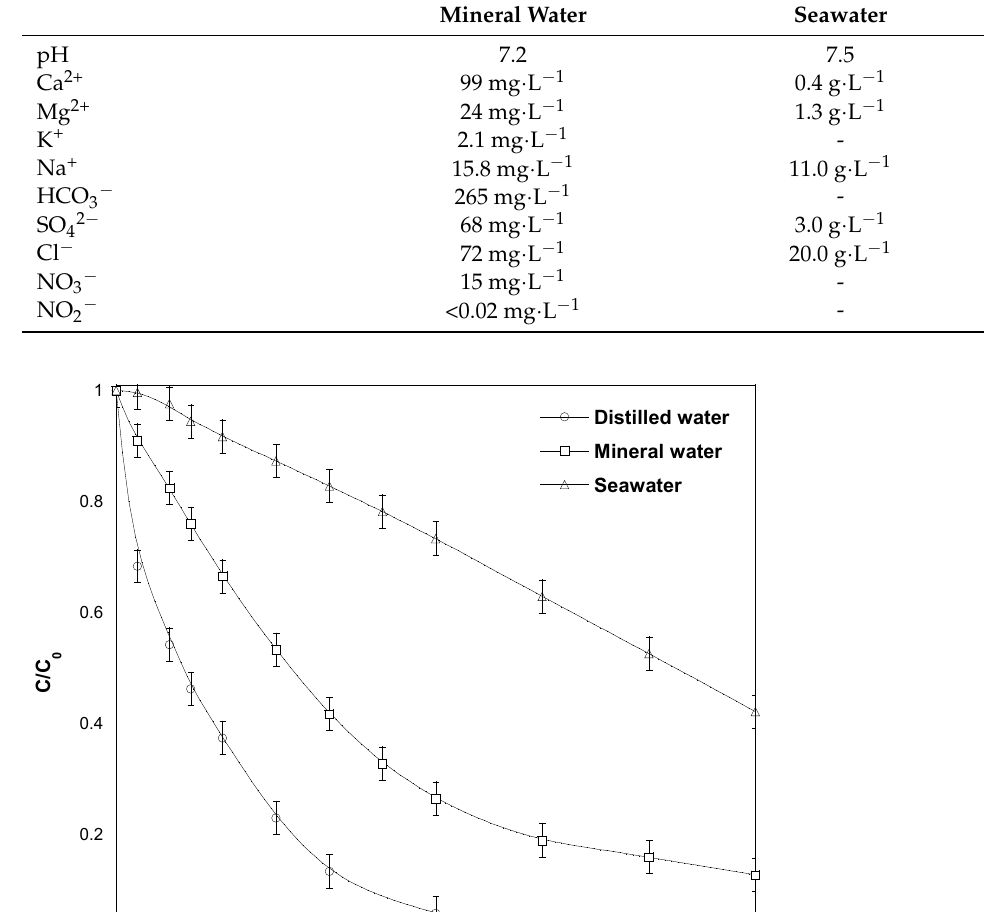
Table 3. Principal characteristics of water matrices used in this study.